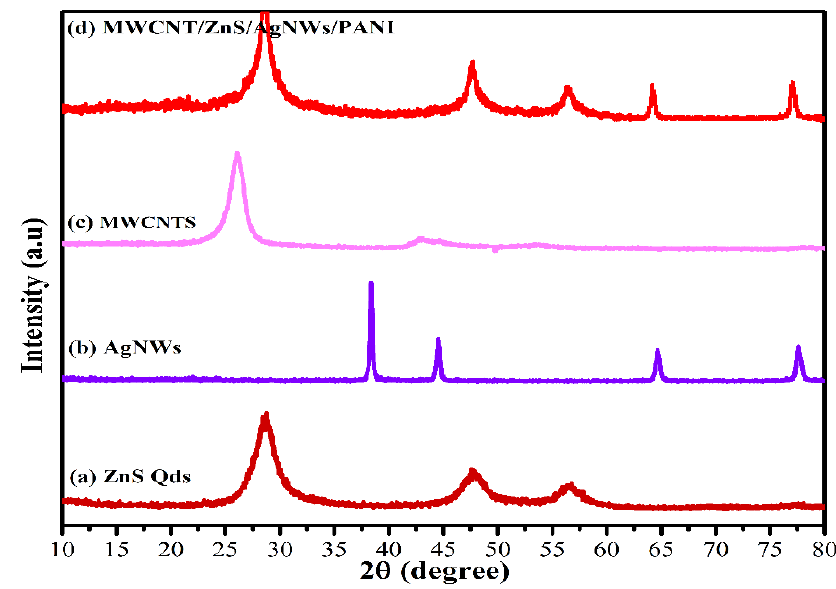
Figure 4. XRD pattern of: ( a ) ZnS Qds; ( b ) AgNWs; ( c ) MWCNTs; ( d ) (MWCNT/ZnS/AgNWs/PANI) Figure 4. XRDpatternof: ( a )ZnSQds;( b )AgNWs;( c )MWCNTs;( d nanocomposite.